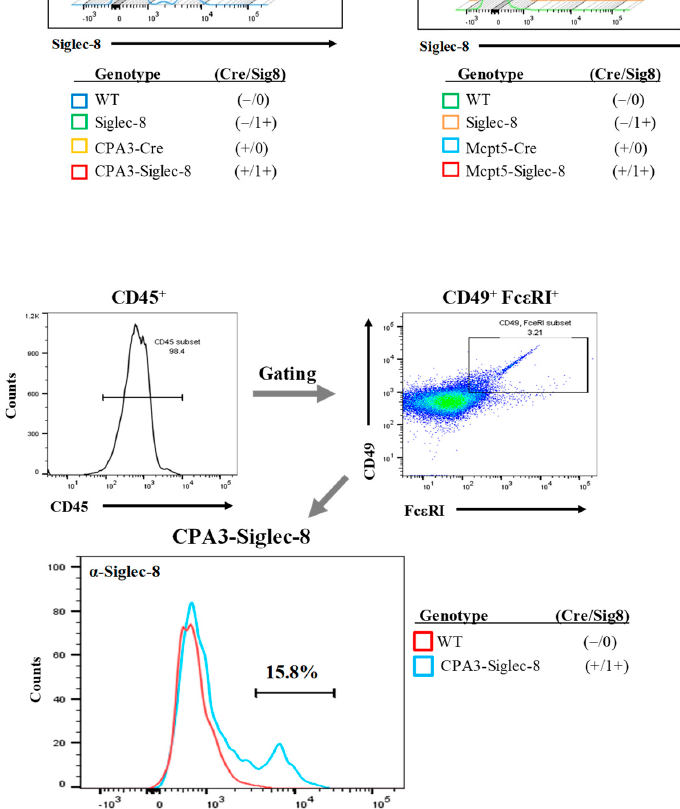
Figure 4. Expression of human Siglec-8 on mast cells and basophils. ( A ) Peritoneal cells were collected from WT ( − /0), ROSA26-Siglec-8 ( − /1+), CPA3-Cre (+/0) or Mcpt5-Cre (+/0), and CPA3-Siglec-8 (+/1+) or Mcpt5-Siglec-8 (+/1+) mice, and expression of Siglec-8 was determined by flow cytometry using anti-Siglec-8 mAb after gating for CD45 + Fc ε RI + c-Kit + (CD117) mast cells. Panels are plots of anti-Siglec-8 stained cells from CPA3-Siglec-8 and Mcpt5-Siglec-8 mice and their corresponding controls. The numbers are percentages of anti-Siglec-8 mAb stained cells. Shown are representative results from three independent sets of experiments; ( B ) peritoneal cells from CPA3-Siglec-8 and WT mice were analyzed for Siglec-8 expression on CD45 + Fc ε RI + CD49b + basophils. Shown are representative results from two separate experiments.